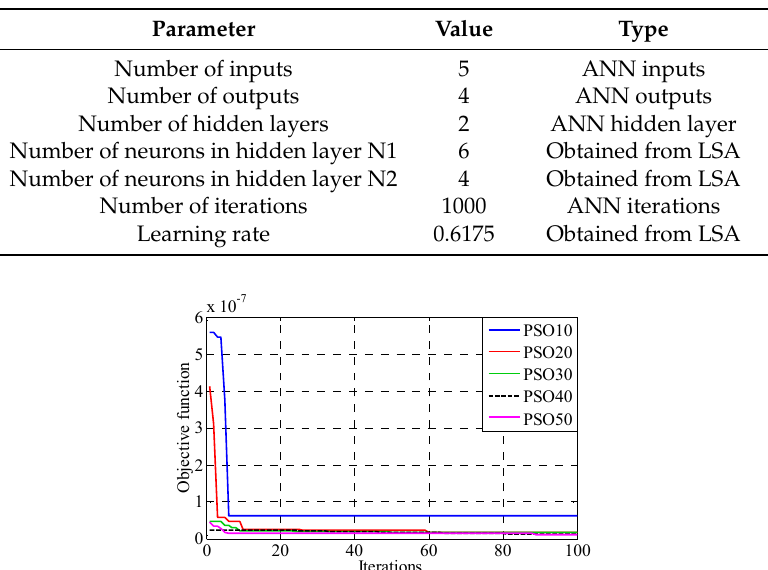
Table 1. ANN ‐ designed parameters. Table 1. ANN-designed parameters.